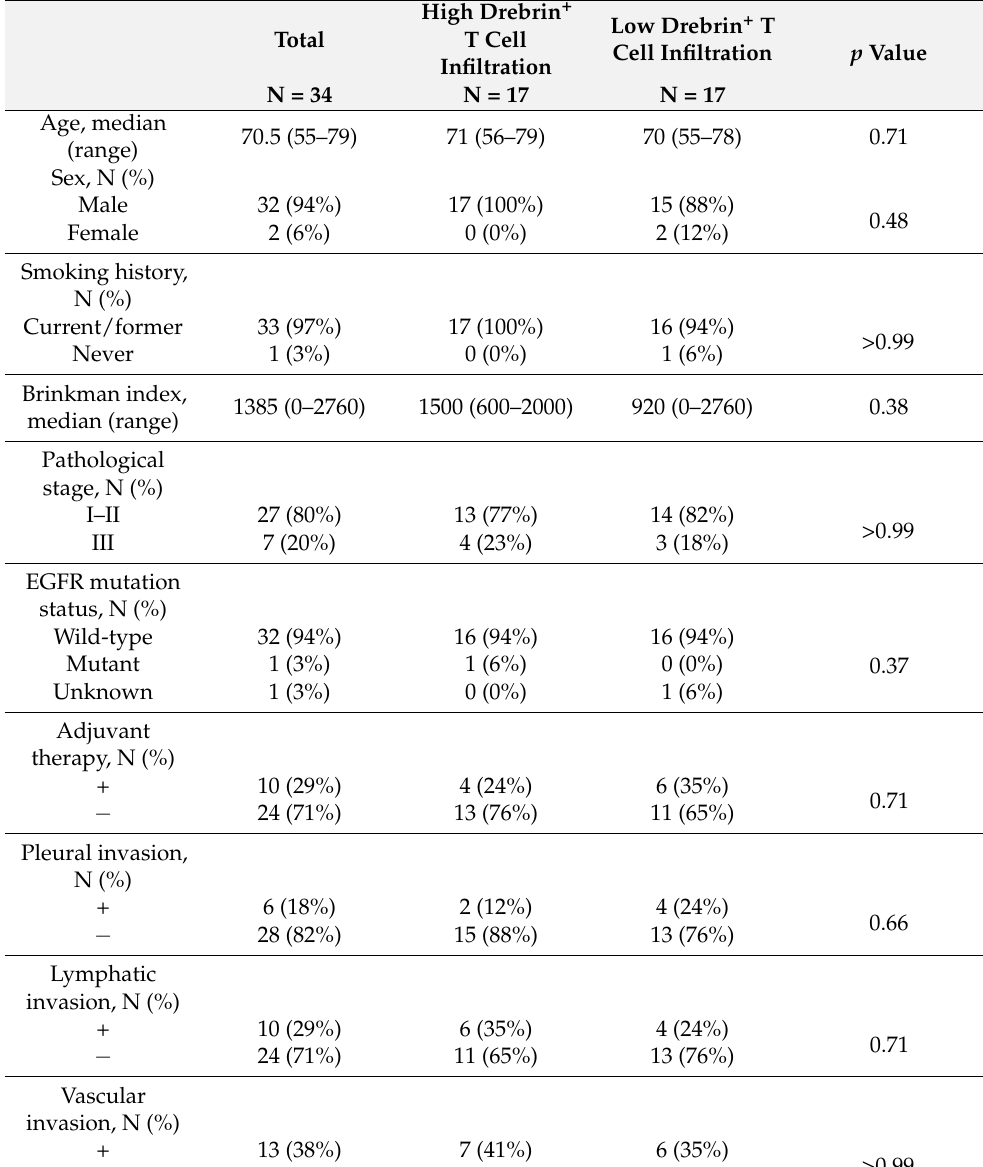
Table 1. Baseline characteristics of 34 patients with Sq undergoing curative surgery stratified by the infiltration of drebrin + TILs. High Drebrin + Total T Cell